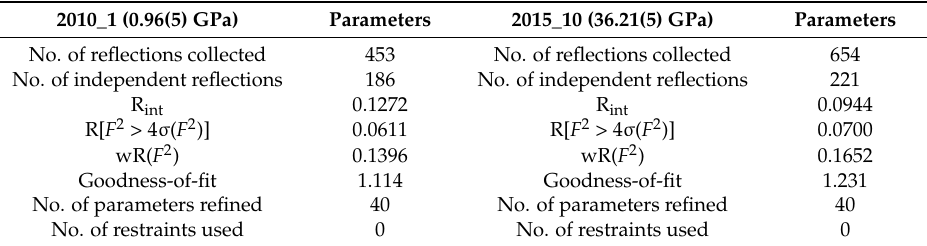
Table 1. Selected data collection and refinement details from lowest and highest pressure points. The opening angle of the diamond anvil cell in the 2015_10 experiment was larger by 20 ◦ compared to the 2010_1 experiment, producing higher number of observed peaks.